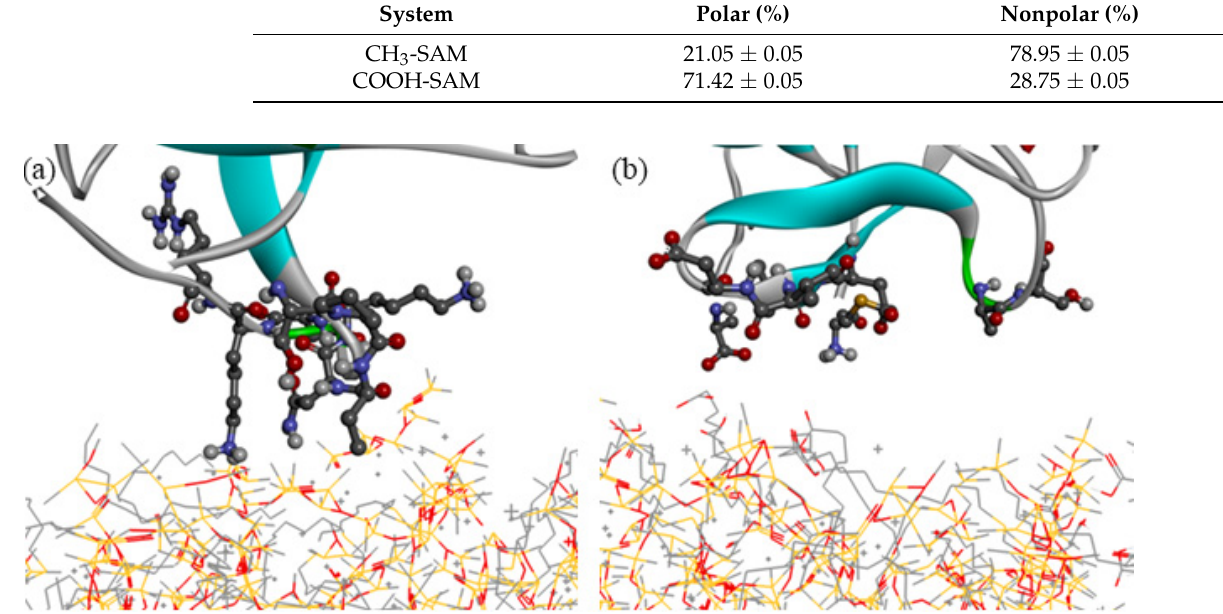
Table 1. Statistics of residue types of mussel protein on polymer membrane surface.